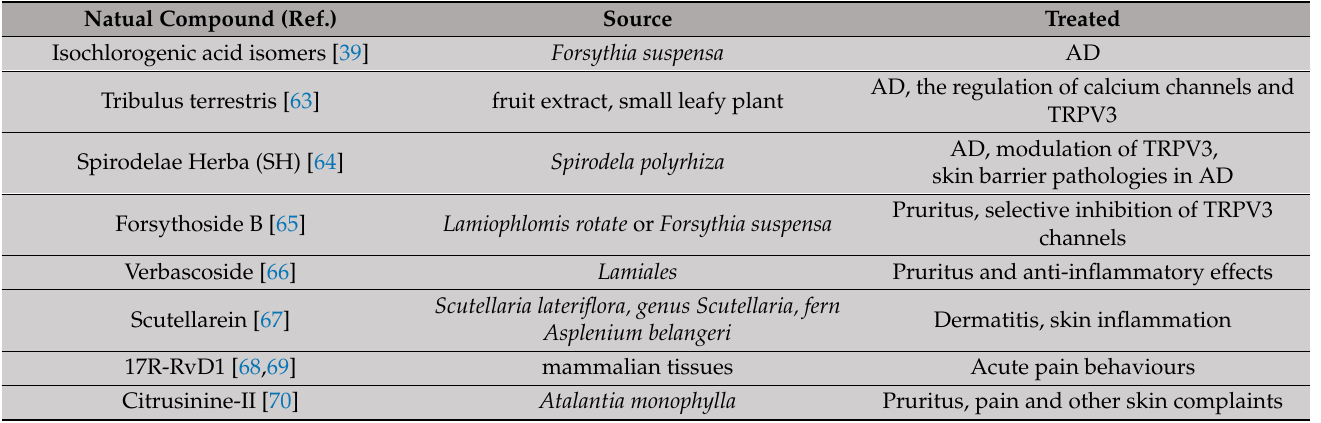
Table 2. Natural TRPV3